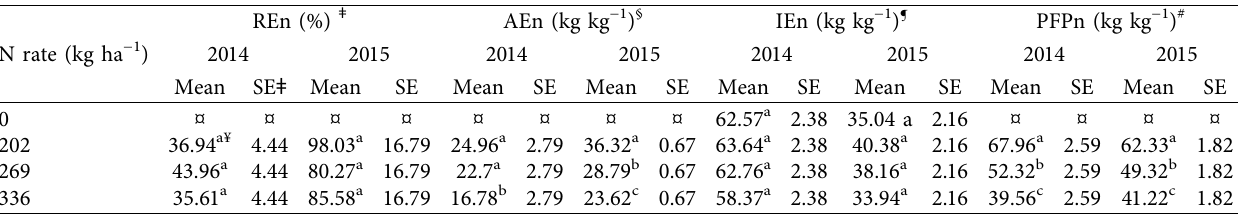
Table 8: Nitrogen recovery efficiency (RE n ), nitrogen agronomic efficiency (AE n ), nitrogen internal efficiency (IE n ), and nitrogen partial productivity (PFP n ) at four N rates (0, 202, 269, and 280kg N ha − 1 ) in 2014 and 2015 at